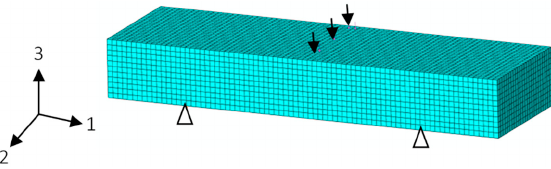
Figure 8. FE model of the short-beam specimen.